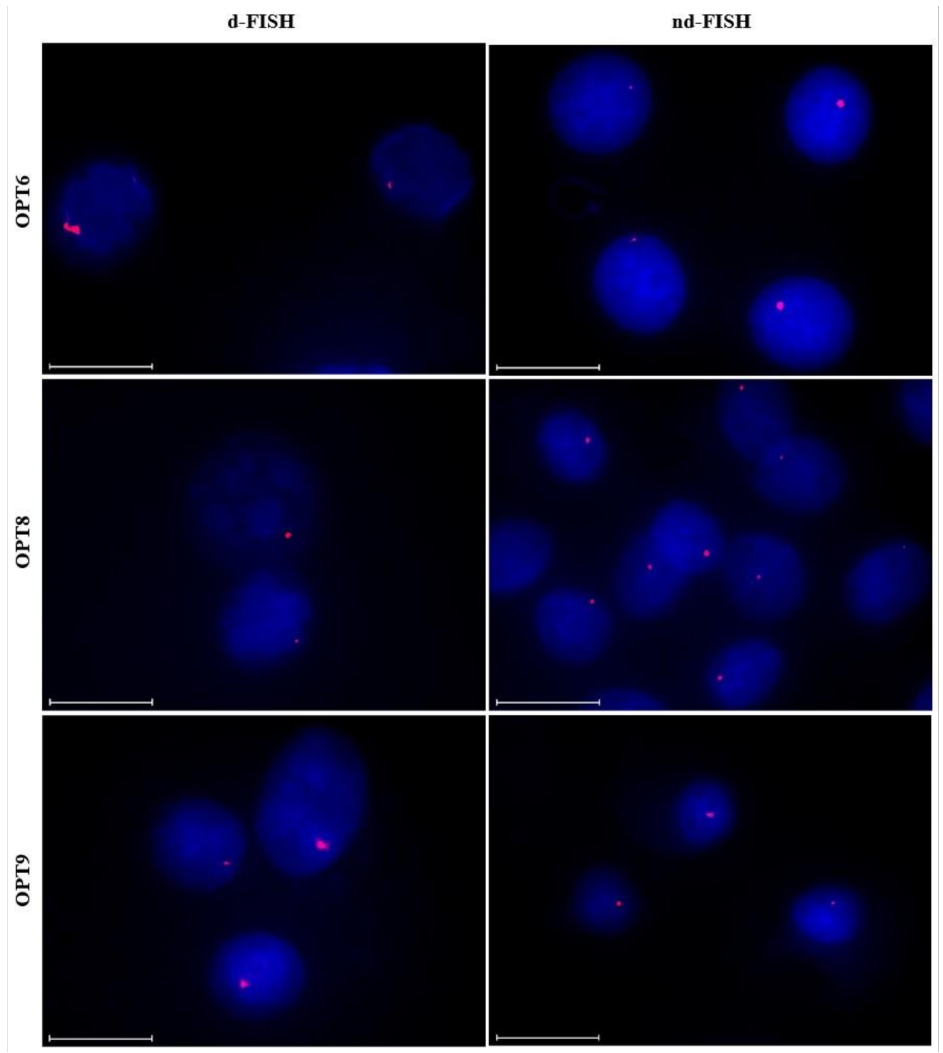
Figure 9. Representative images from FISH experiments in which optimized DYZ1 -targeting Invader probes OPT6 , OPT8 , and OPT9 (upper, middle, and lower panel, respectively) were incubated with isolated nuclei from a bovine kidney cell line under denaturing (5 min, 80 ◦ C, left) or non-denaturing (3 h, 37.5 ◦ C, right) conditions. Incubation conditions and the image capture process are as described in Figure